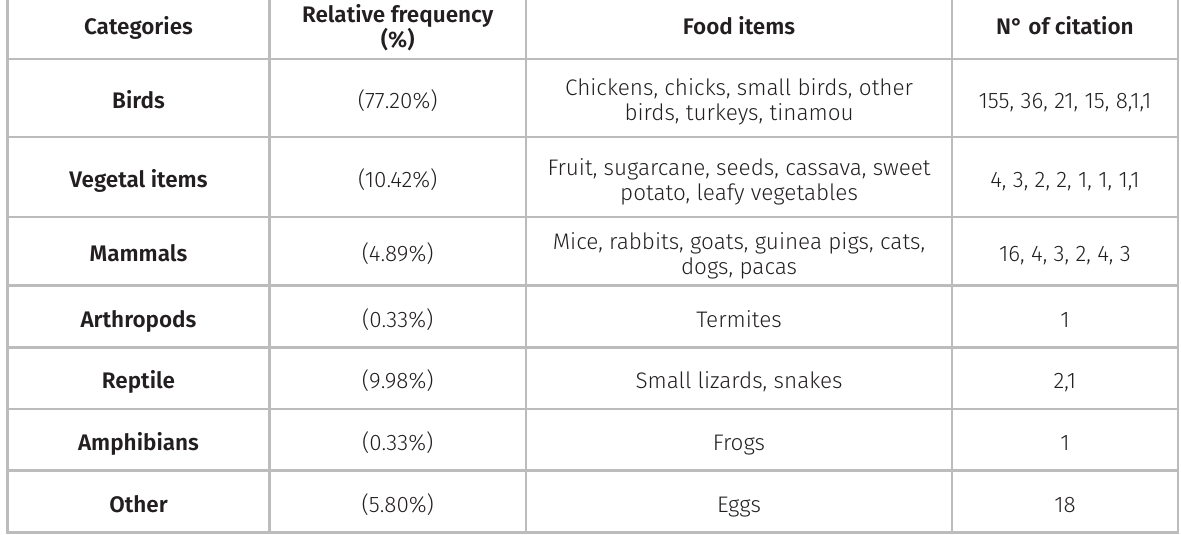
Table II. Food items consumed by crab-eating fox mentioned by